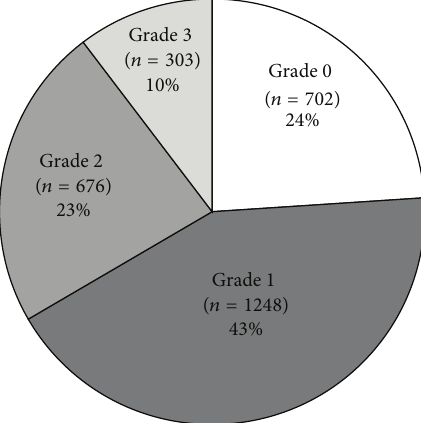
Figure 1: Distribution of hepatic fat by steatosis grades ( 𝑛 = 2929 ).